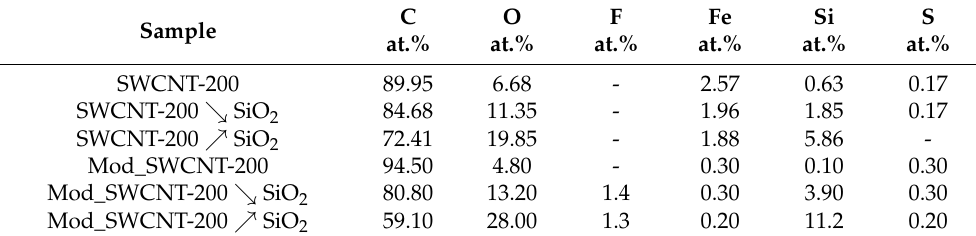
Table 6. Elemental composition of prepared membranes obtained by SEM–EDS.